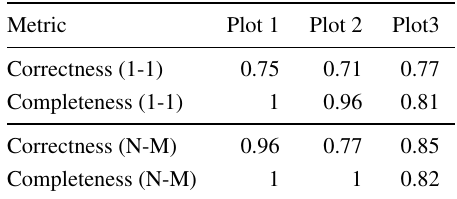
Table 1. Evaluation of detection results - correctness and com- pleteness for object-level